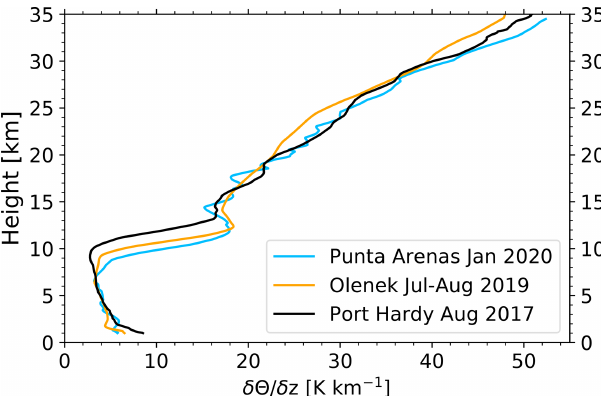
Figure 5. Gradient of the potential temperature at Punta Are- nas (Chile; 53.17 ◦ S, 70.93 ◦ W; January 2020), Olenek (Russia; 68.50 ◦ N, 112.43 ◦ E; July–August 2019), and Port Hardy (Canada; 50.68 ◦ N, 127.36 ◦ W; August 2017) obtained from radiosonde data (Uni-Wyoming, 2022) and used in the self-lofting simulations (see Fig.